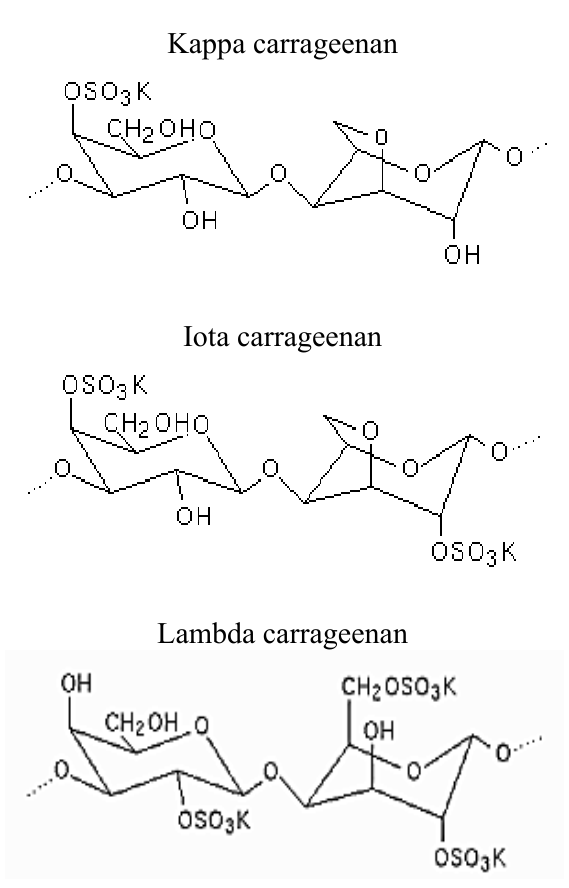
Figure 9. Structure of Kappa, Iota and Lambda type of